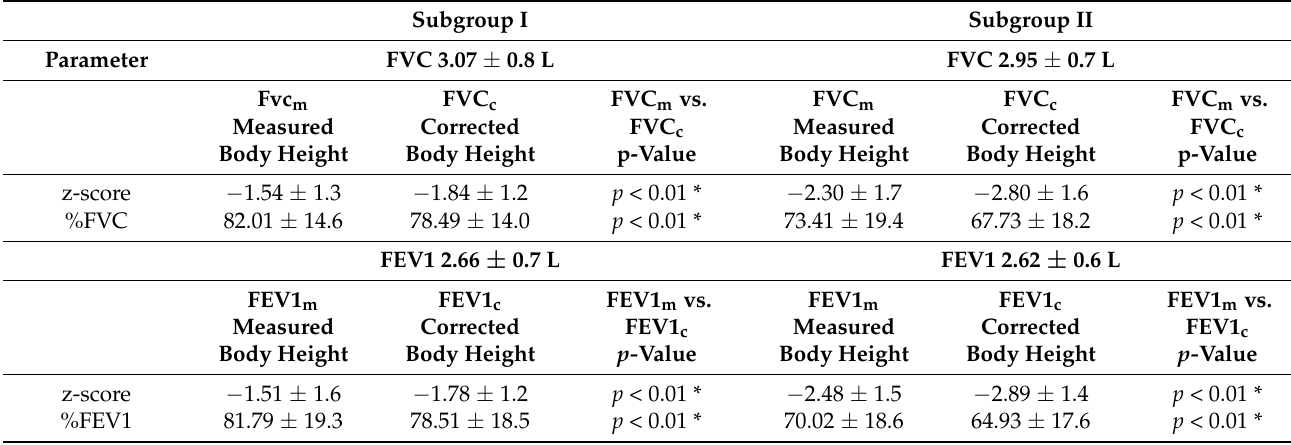
Table A5. Comparison of the pulmonary parameters calculated for the measured versus the corrected body height in subgroup I, N = 54 and subgroup II, N = 19, Lenke 1 type.